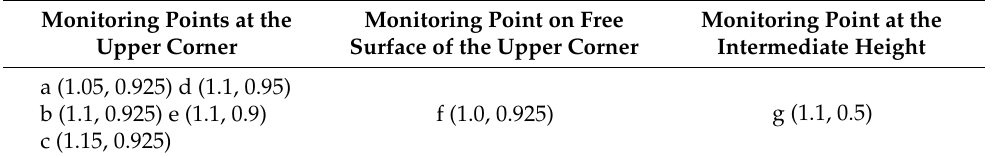
Table 3. Layout of monitoring points in liquid